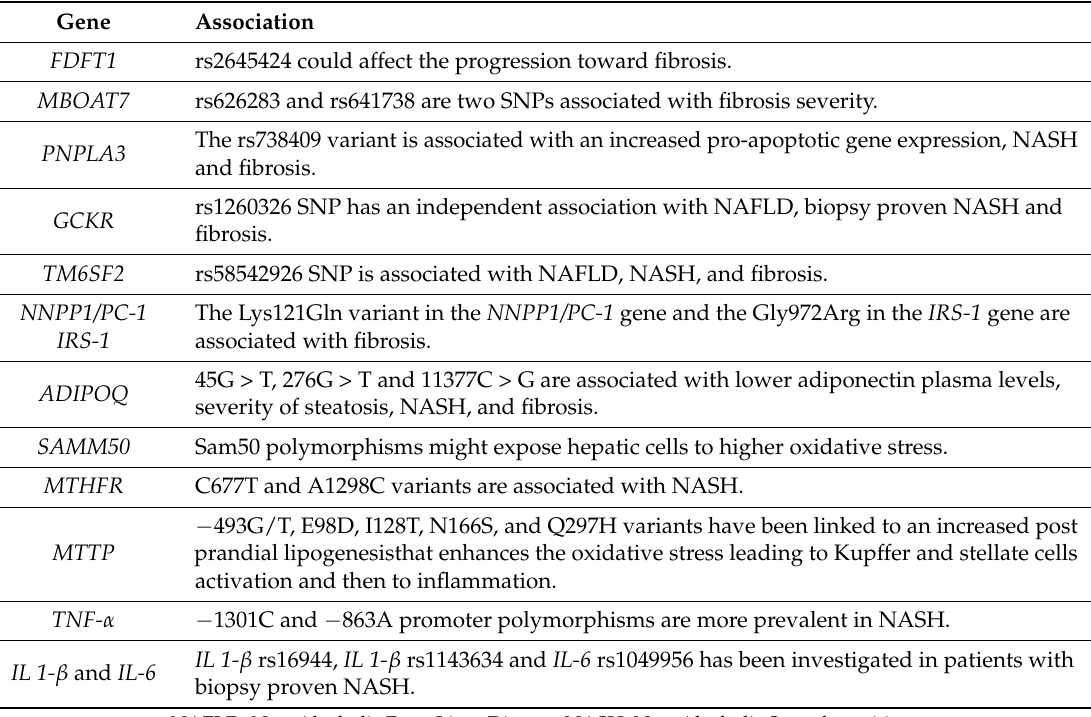
Table 2. Genes involved in NAFLD